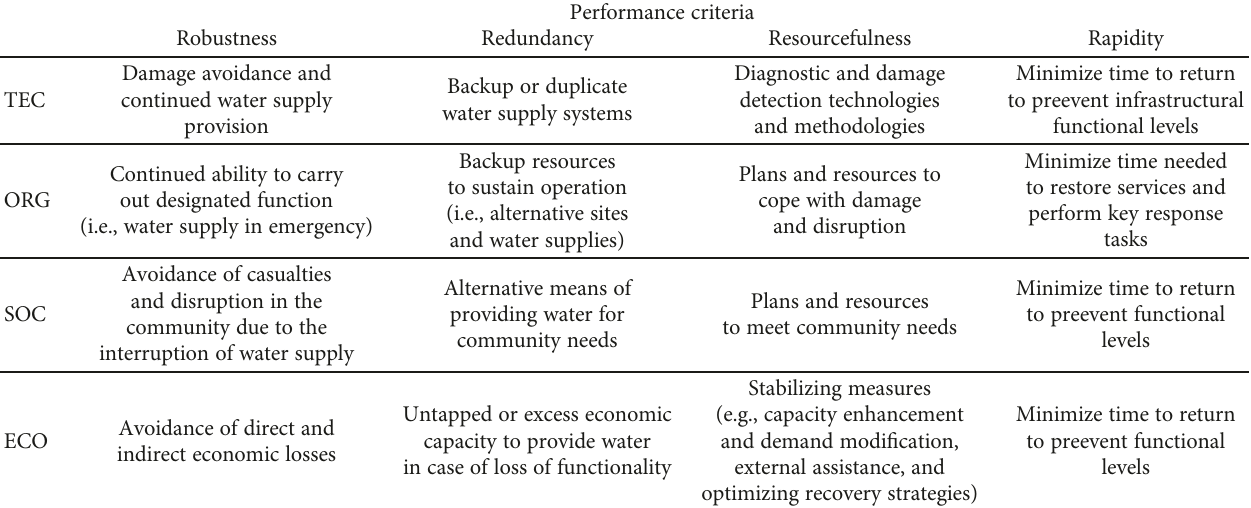
Table 1: Performance criteria according to the TOSE approach (adapted from